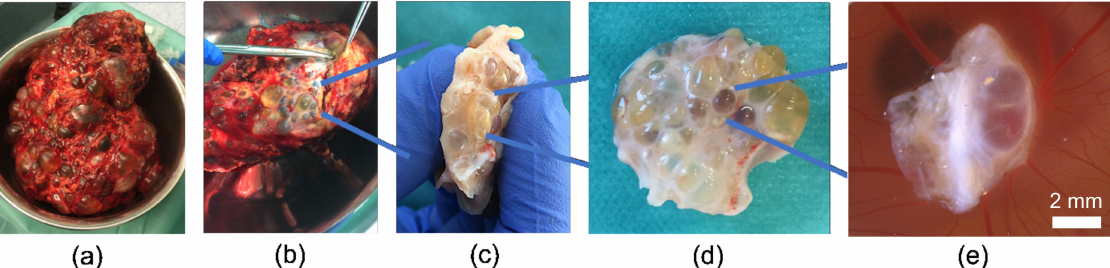
Figure 2. Workflow from the nephrectomy to the engraftment on the 3D in vivo model; ( a ) entire human kidney from a patient suffering from ADPKD; ( b ) dissection of capsula adiposa; ( c , d ) dissected cystic tissue; and ( e ) renal cystic tissue implanted on the